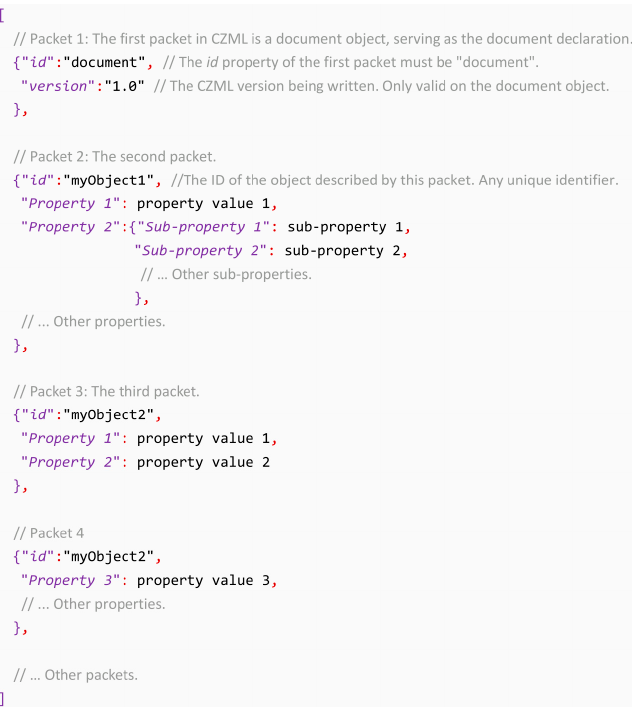
Figure 1. General structure of a CZML document. The first packet (Packet 1) in a CZML document